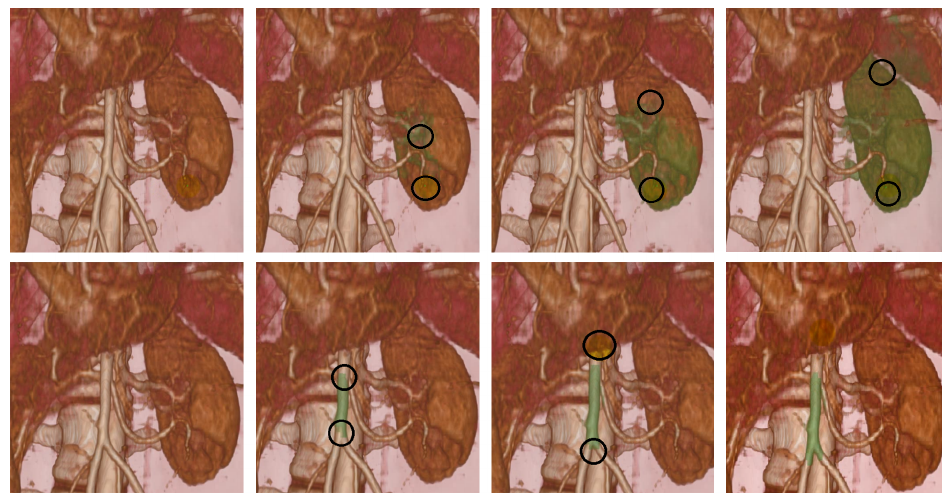
Figure 6. Two examples of dynamic growth of selected handles, in green, both on large and thin anatomy. The black circles represent p i and p t , i.e., the screen-space positions of the index and the thumb. Note that the change of color occurs in the volumetric medical image representation; it is not a simple change of color of the rendered image. As the green color is constrained to the selected anatomical elements (kidney and vein), the figure demonstrates the success of the volumetric selection, i.e., no green pixels bleed to other regions of the data set.